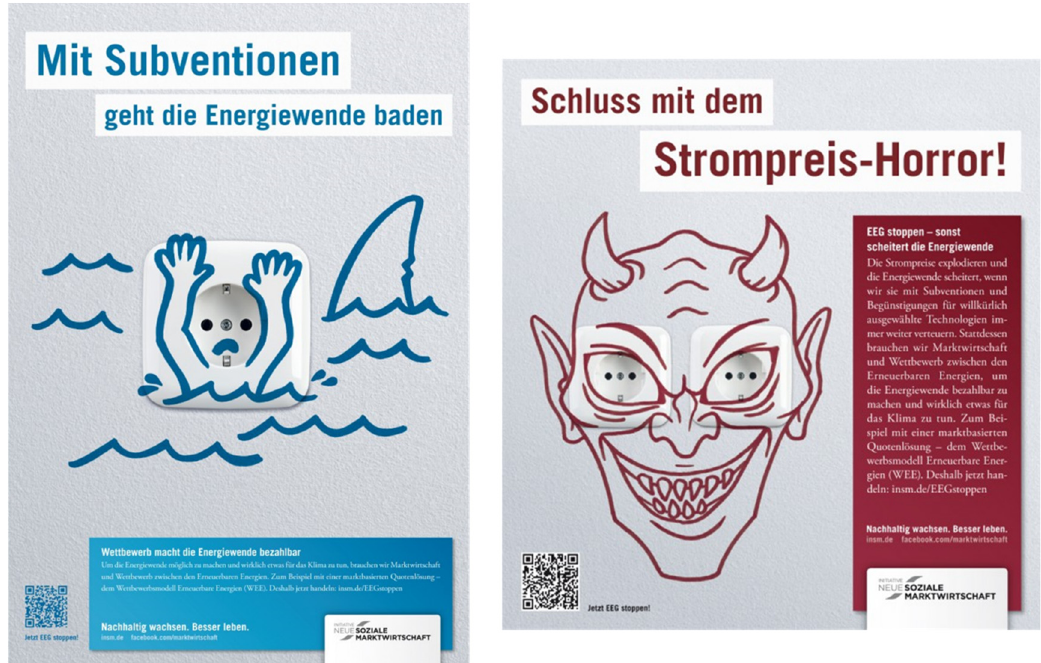
Figure 5. “With subsidies, the energy transformation will drown” ( left ) and “Put an end to the horror of electricity prices” ( right ). These print advertisements against over-subsidised renewables triggering rising electricity prices werepart of the 2012 public campaign, “Stop the EEG now!” Source: Reprinted with permission from Ref. [144]. 2012, Initiative Neue Soziale Marktwirtschaft (INSM).